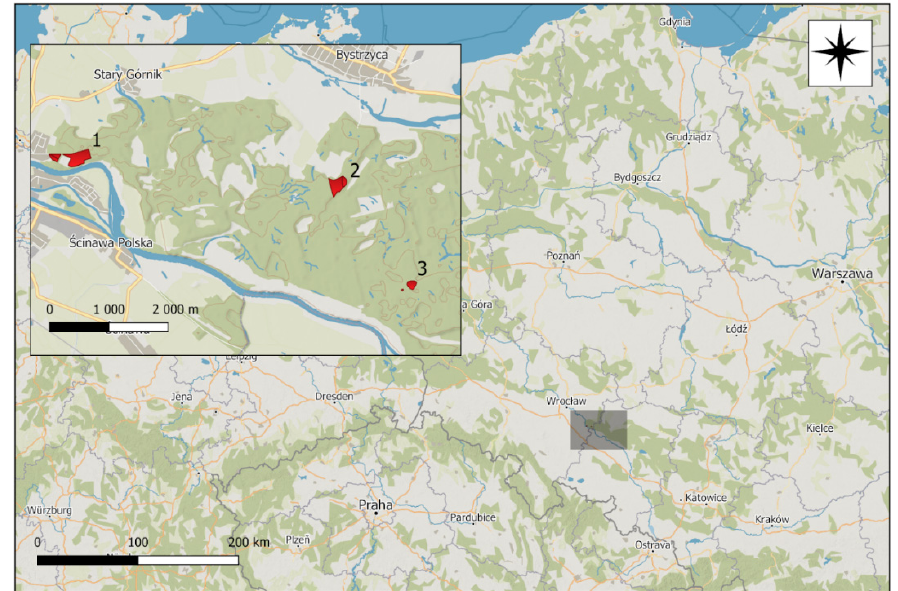
Figure 1. Location of the study area (gray rectangle) in SW Poland. Studied nature reserves are marked in red (1—Zwierzyniec; 2—Kanigóra; 3—Grodziska Ryczy ń skie). Forests are marked in green. Background from the © MapTiler © OpenStreetMap contributors.